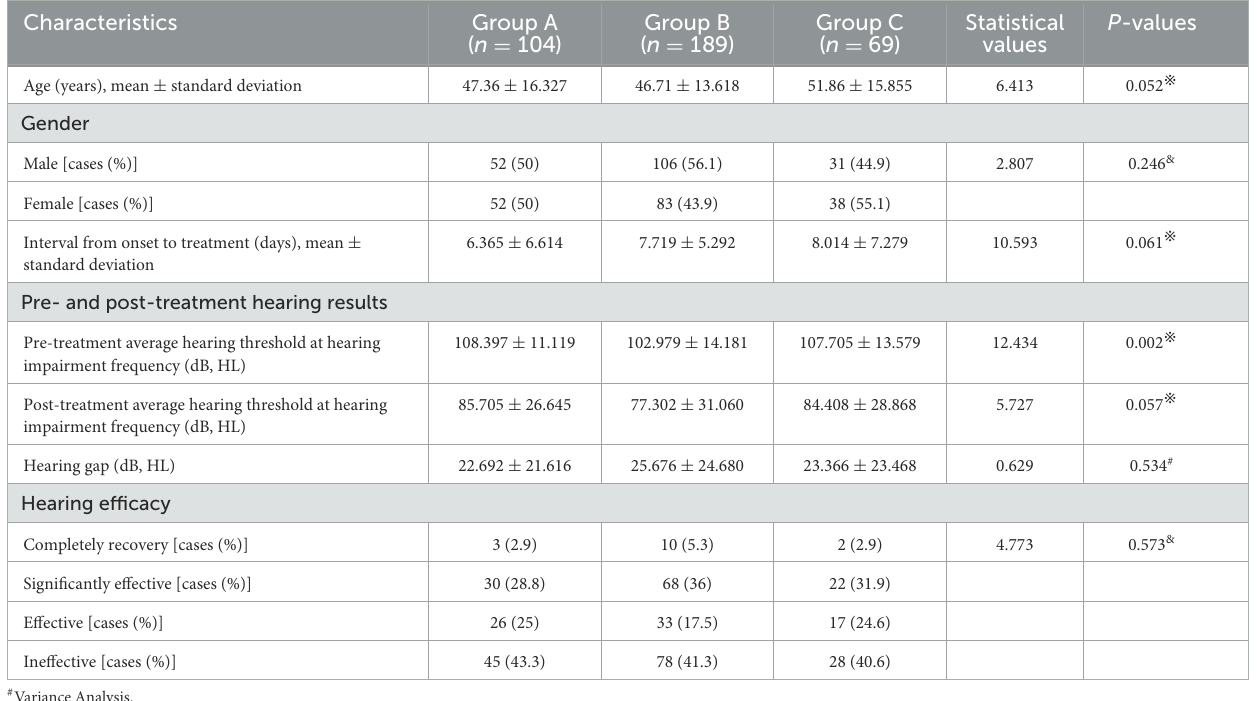
TABLE 7 Clinical characteristics and hearing efficacy of patients with profound SSNHL in the three groups. Characteristics